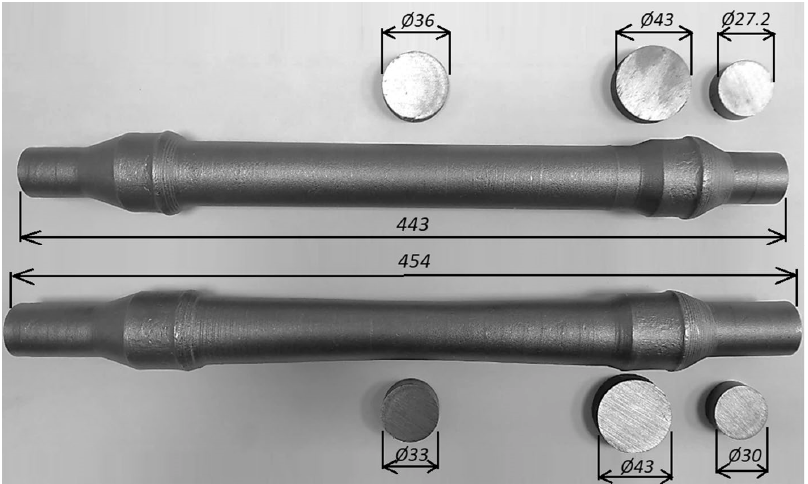
Figure 17. Rail axles produced in 1:5 scale after machining allowance removal and shot peening [20] (Reprinted from ref. [20]).